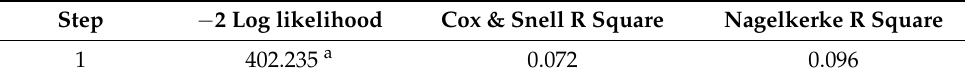
Table 14. Model summary.